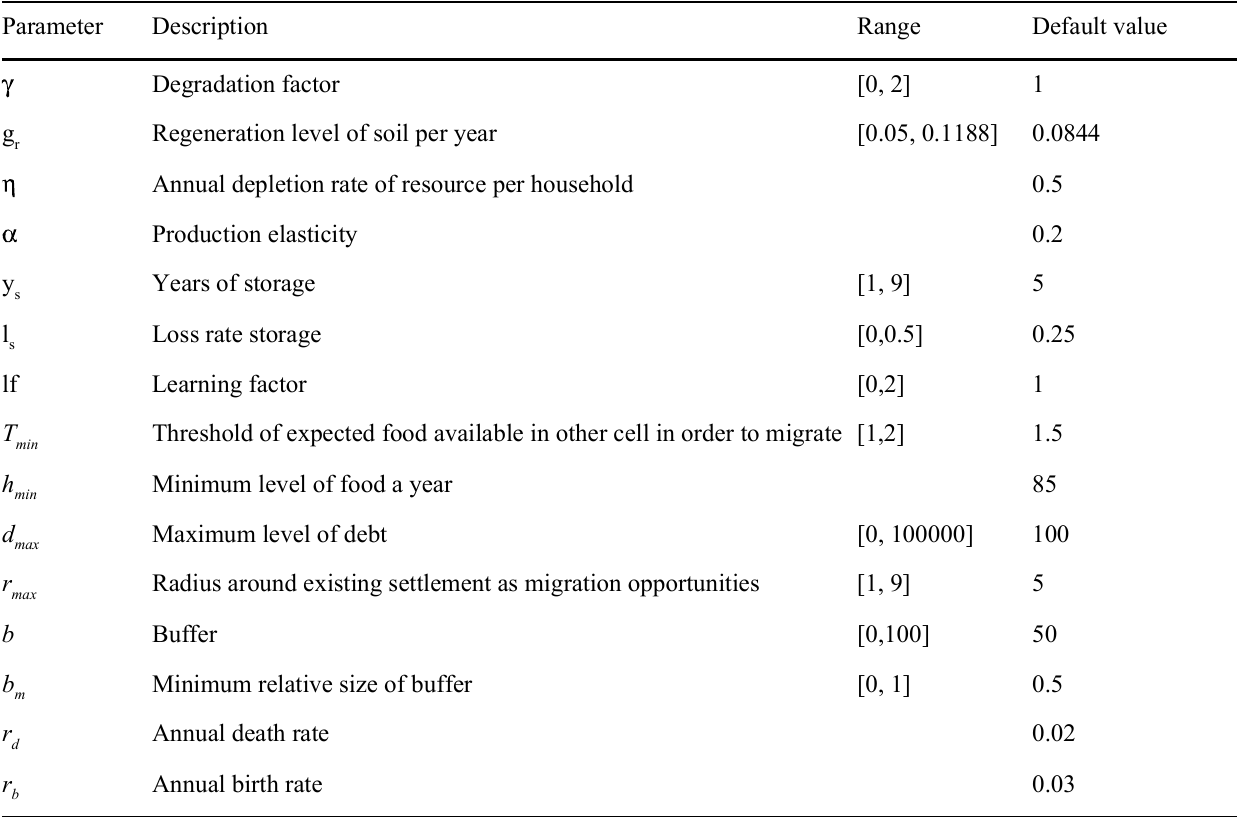
Table 2. Parameter values of the default version of the model.